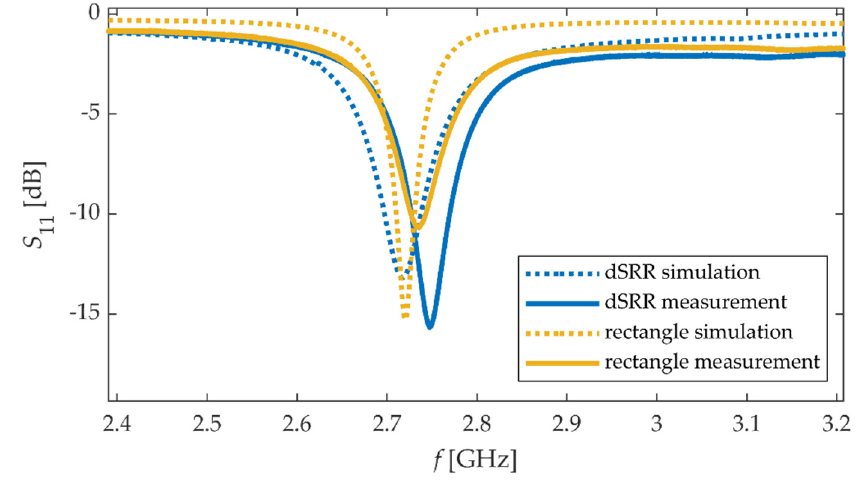
Figure 3. Calculated and measured module of reflection coefficient S 11 for considered sensors.